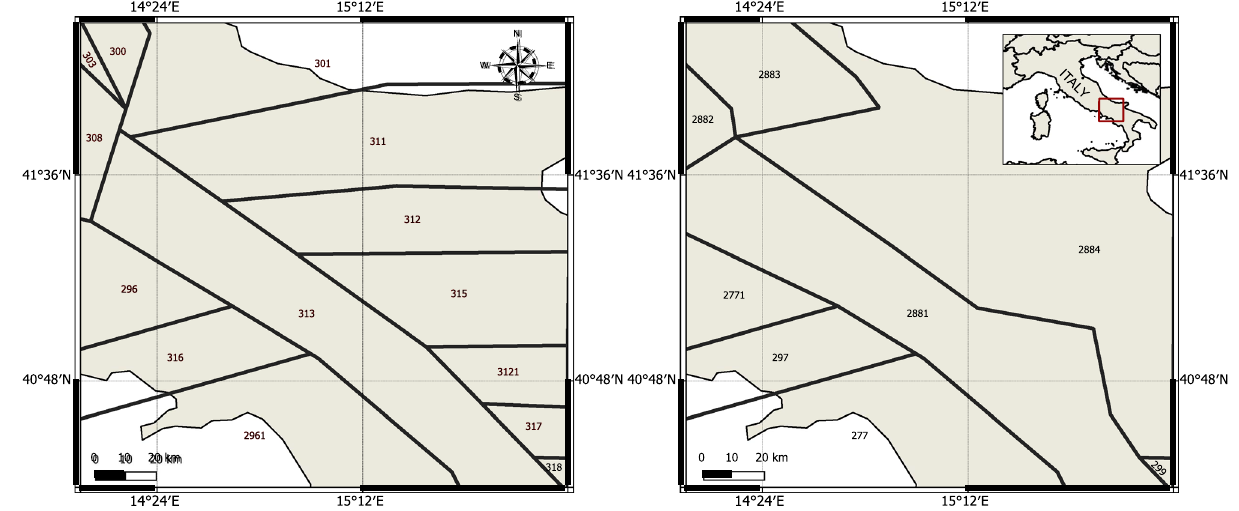
Figure 8. Seismic source models used for the assessment of the seismic hazard of the study region; left: area source model; right: fault source and background model; 13 . This figure is created with QGIS version 3.18.2 (https:// www. qgis.